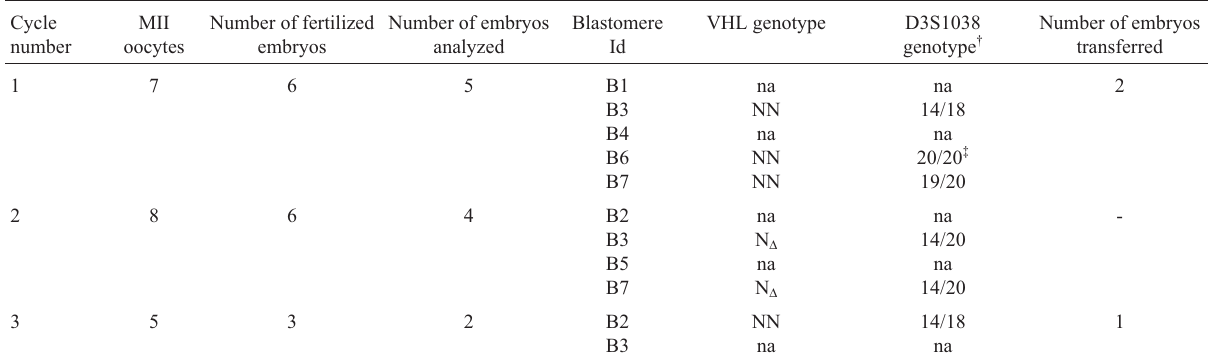
Table 3 - Results of pre-implantation diagnosis of Von Hippel-Lindau (VHL) disease during three in vitro fertilization cycles. Cycle number